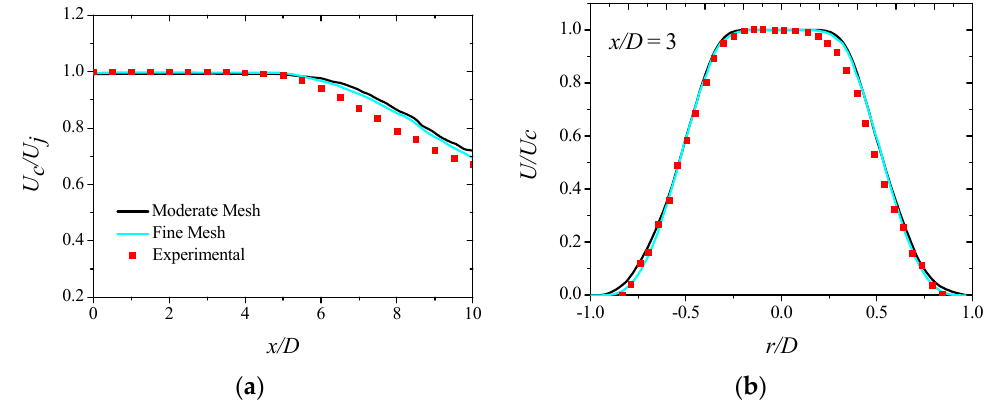
Figure 3. Comparison of the time-averaged axial velocity profile between the simulation and exper- iment ( a ) along the centerline [20] ad ( b ) along the radial direction at x / D = 3. A uniform velocity without considering boundary layer and fluctuation was used at the nozzle entrance, resulting in bulk velocity U j = 10 m/s at the nozzle outlet. For wall boundaries, the no-slip condition was used. Non-reflective boundary conditions imple- mented by solving a convective equation were employed at outflow. To allow entrainment at the circumferential boundary, free stream conditions were applied. The pulsed jet was achieved by switching the velocity magnitude from 0 to target value with a 0.5 duty cycle. The two pulsed jets are working with 180° phase difference. The amplitude of the pulsed jet was adjusted by the velocity magnitude of the actuator inlet.